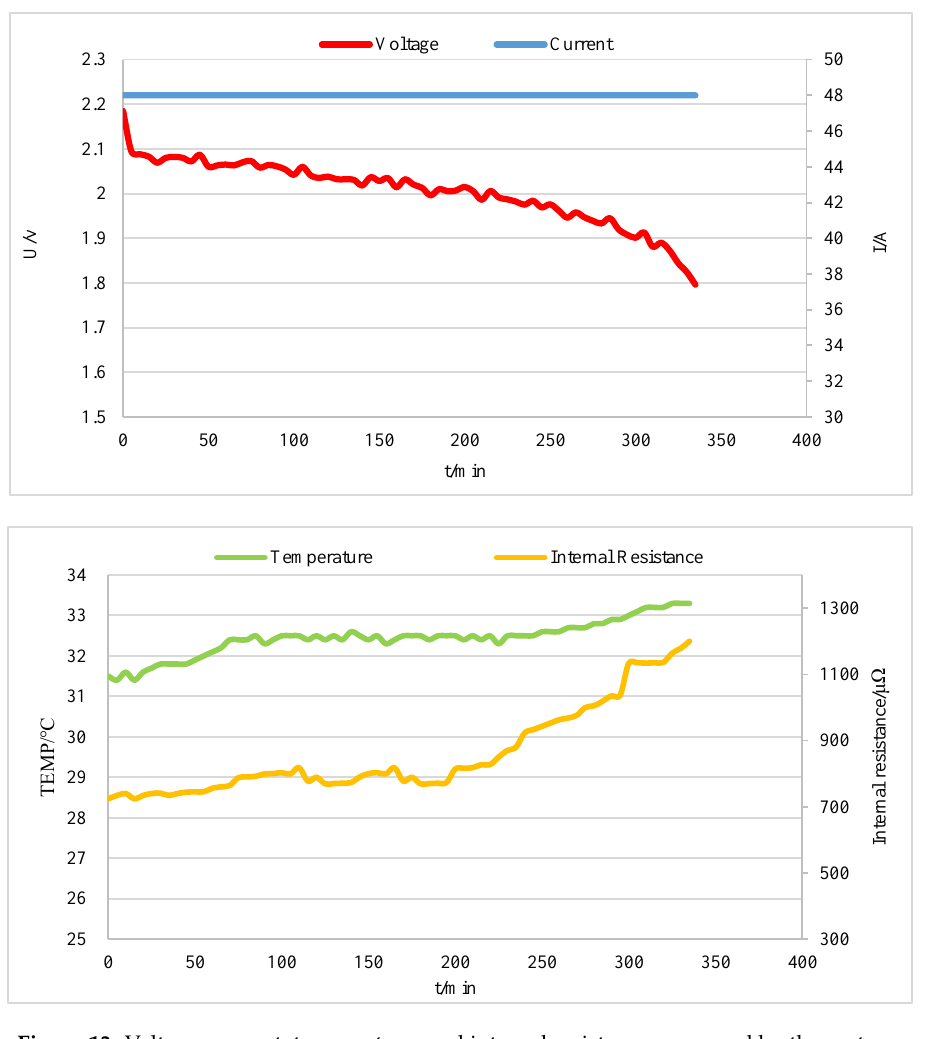
Figure 13. Voltage, current, temperature, and internal resistance measured by the system.